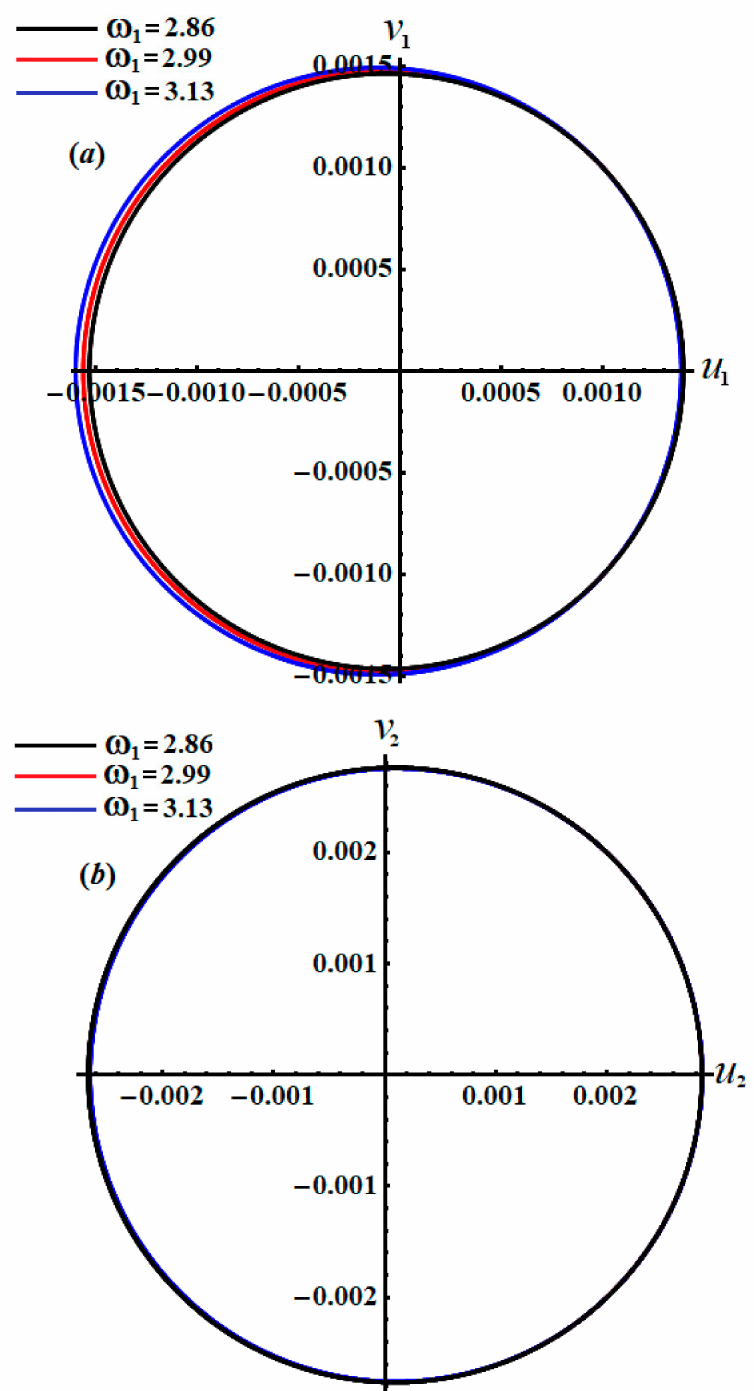
Figure 14. Illustration of the projections of the equations of modulation paths when ω 1 = ( 2.86,2.99,3.13 ) : ( a ) on the plane u 1 v 1 , ( b ) on the plane u 2 v 2